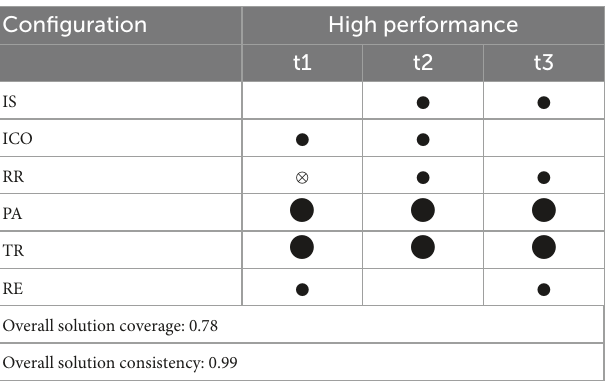
TABLE 3 Configurations of enterprise resilience capabilities for high-performing enterprises. Configuration